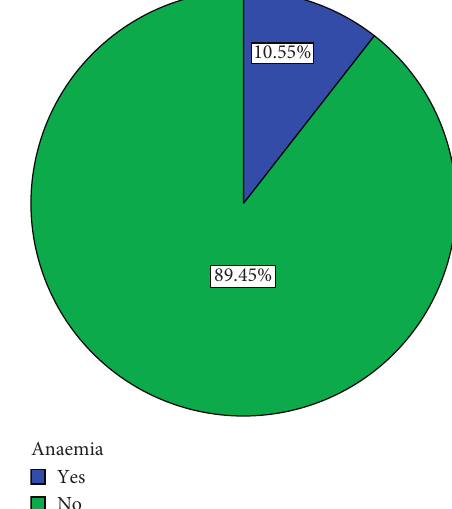
Table 1: Characteristics of the studied population.